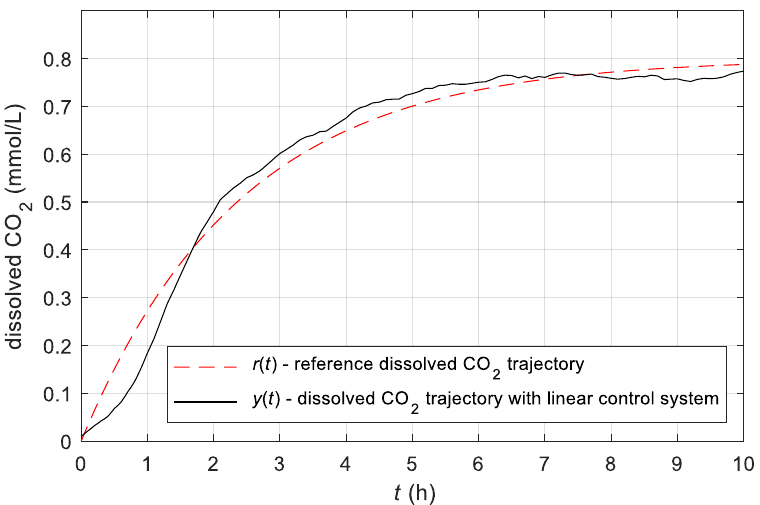
Figure 9. Time responses of the reference and actual dissolved CO 2 concentration of the modified fermentation process in the batch bioreactor; the conventional control system with the linear controller with calculated parameters was used; data of the controlled modified fermentation process with inactivated kefir grains are shown in Table 3; the controller parameters are shown in (22).